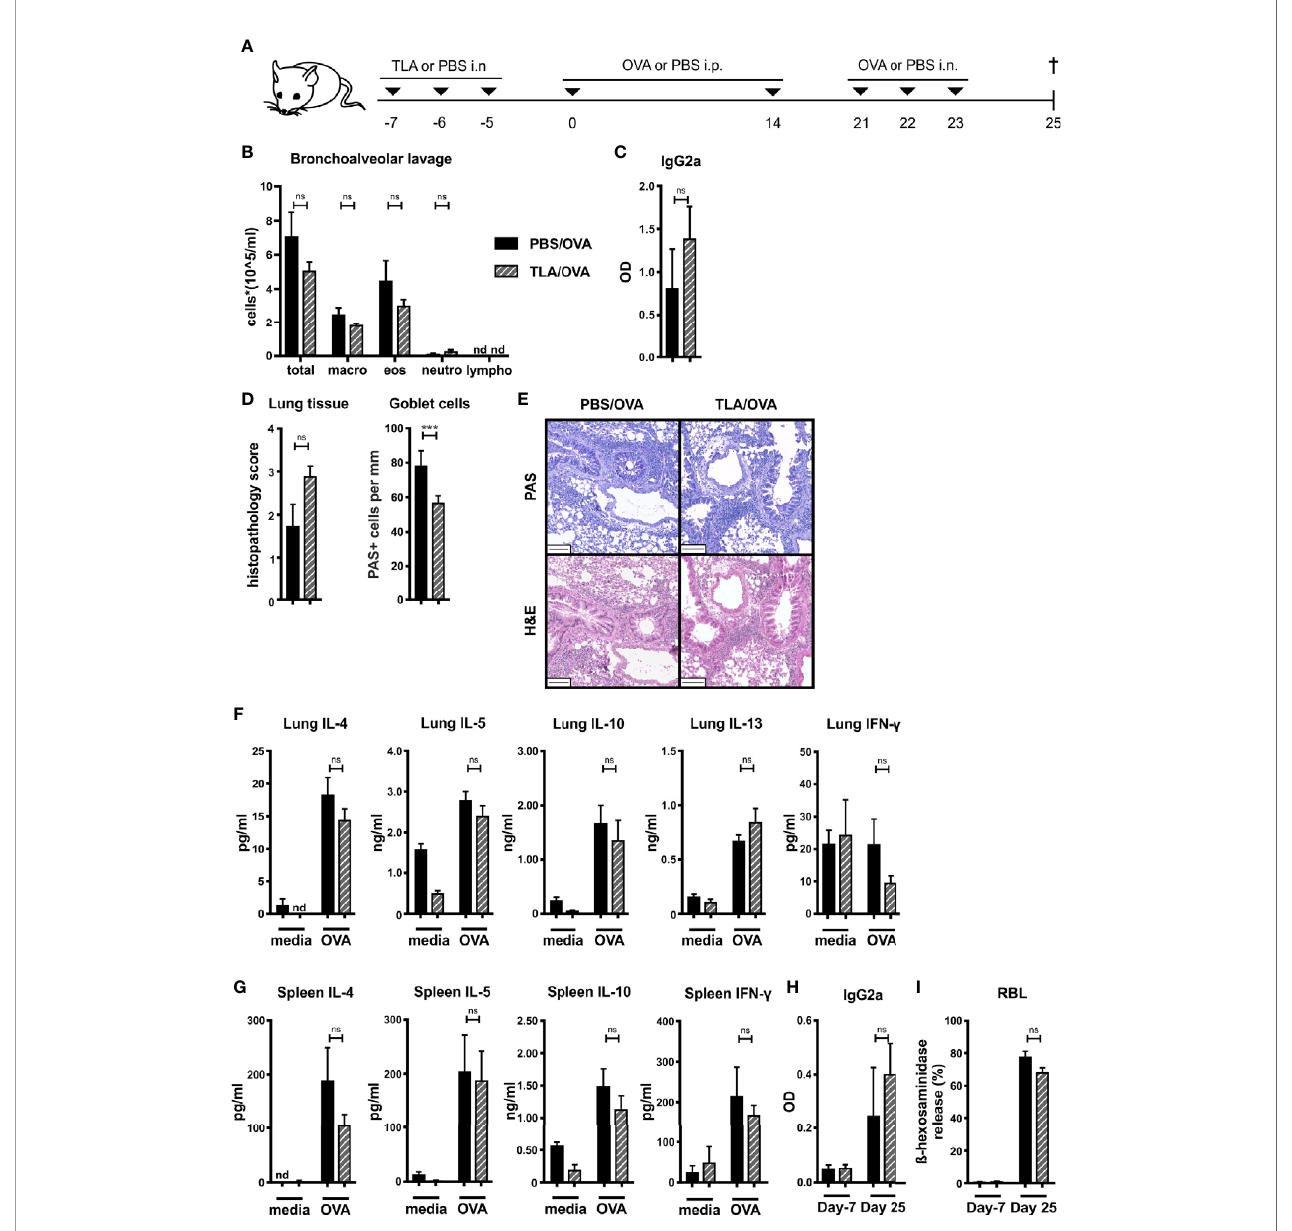
FIGURE 1 | Prophylactic treatment with TLA fails to prevent allergic airway in fl ammation. (A) Experimental design. (B) Differential cell counts in bronchoalveolar lavage (BALF). (C) Levels of OVA-speci fi c antibody IgG2a in BALF collected at the end of the experiment. (D) Average histopathology score and number of Periodic acid- Schiff (PAS)-positive goblet cells of lung sections. (E) PAS or hematoxylin and eosin (H&E)-stained lung sections from 1 representative example from each group (n = 5); scale bars, 100µm. (F) Levels of IL-4, IL-5, IL-10, IL-13, and IFN- g after medium and ovalbumin (OVA) restimulation of lung cells. (G) Levels of IL-4, IL-5, IL-10, and IFN- g after medium and OVA restimulation of spleen cells. (H) Levels of OVA-speci fi c antibody IgG2a in serum collected at the beginning and at the end of the experiment. (I) Release of b -hexosaminidase by rat basophil leukemia (RBL) cells. Graphs show results from 1 representative experiment from 2 independent experiments with 5 mice per group ( Figures 1B – I ). Error bars show mean ± SEM. TLA, tachyzoites lysate antigen; OVA, ovalbumin; i.n., intranasal; i.p., intraperitoneal; macro, macrophages; eos, eosinophils; neutro, neutrophils; lympho , lymphocytes; OD, optical density; nd , not detectable; ns , not signi fi cant; ***P <